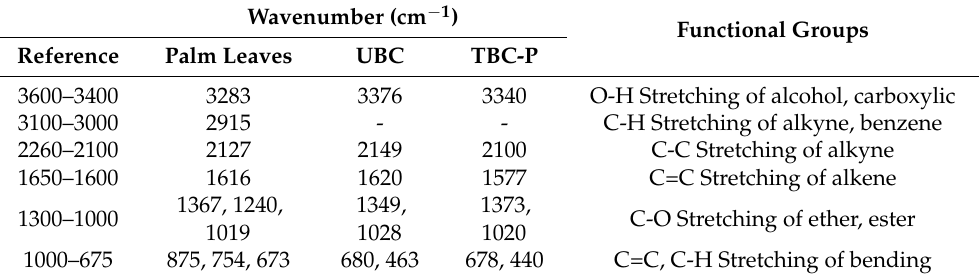
Table 1. FT-IR functional groups on palm leaves, UBC and TBC-P adsorbent.